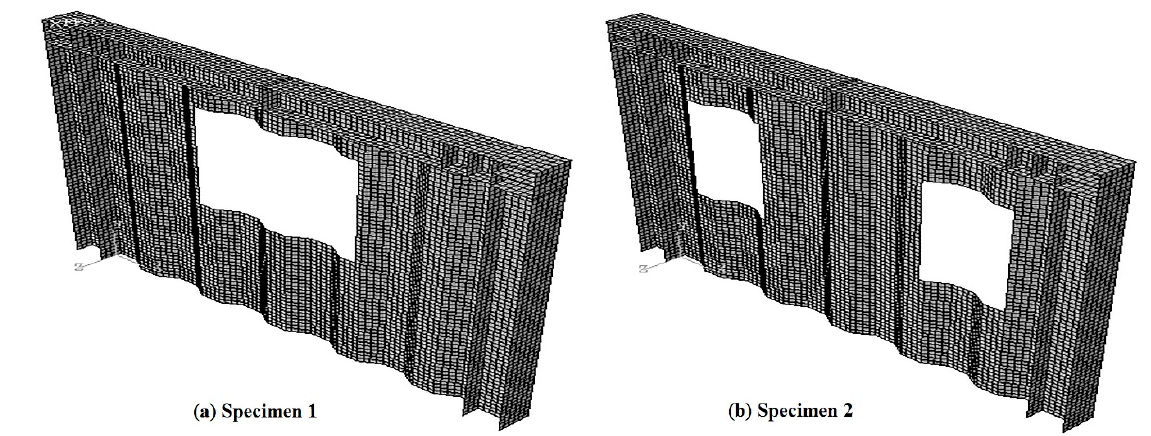
Figure 18. Finite element models of tested specimens.